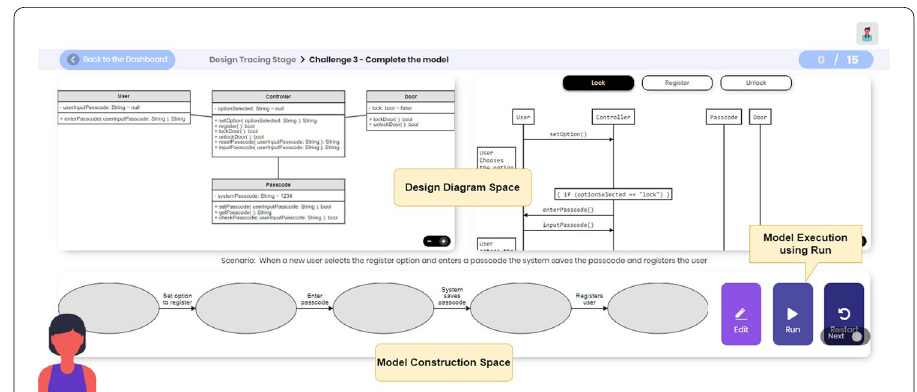
Fig. 10 Various spaces in the Design Tracing Stage challenges